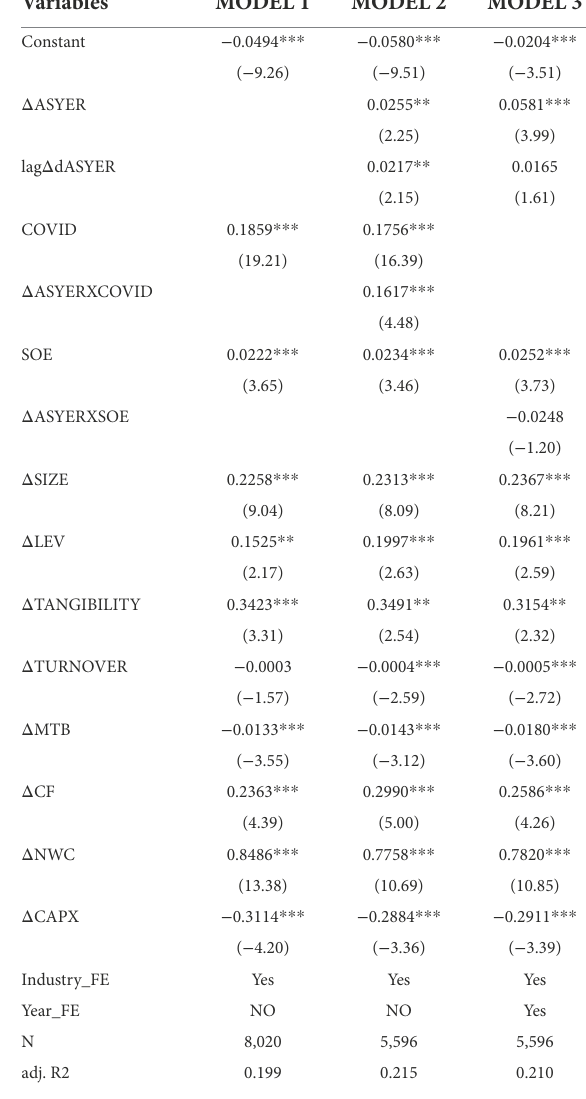
TABLE 8 Robustness checks using changes in the